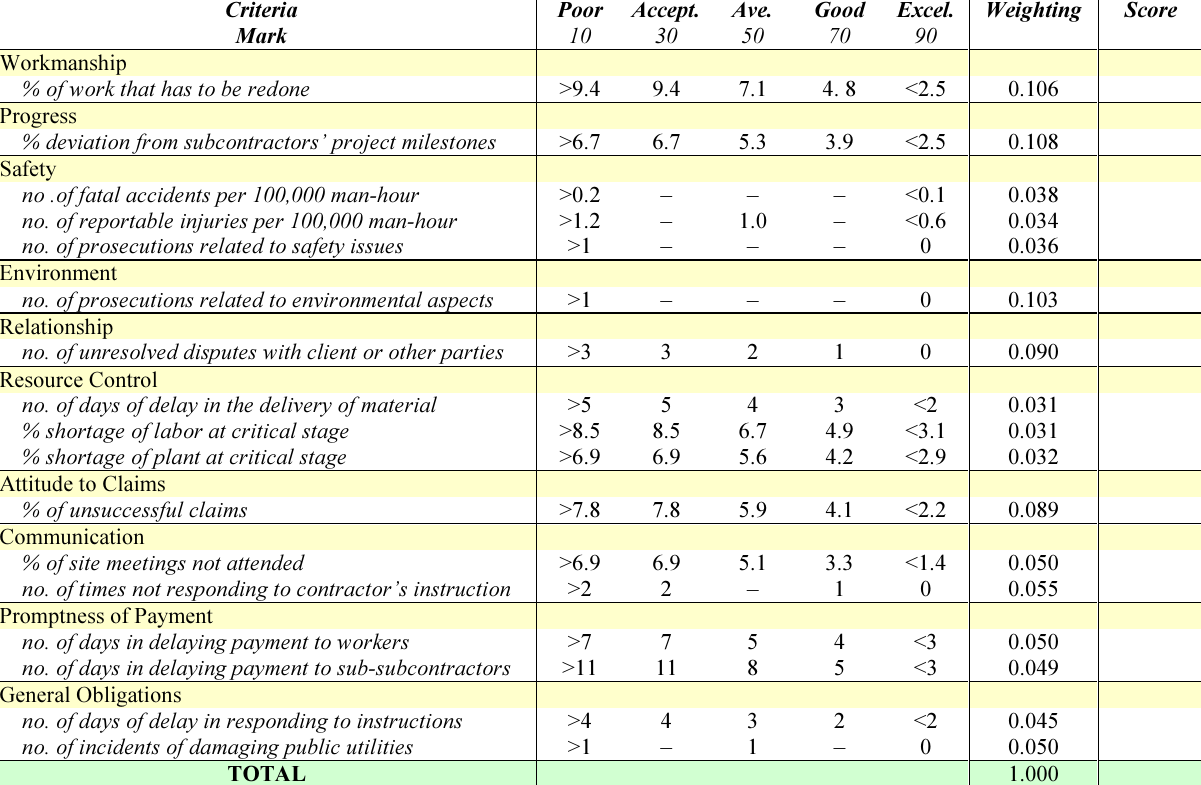
Fig. 1. The proposed balanced scorecard